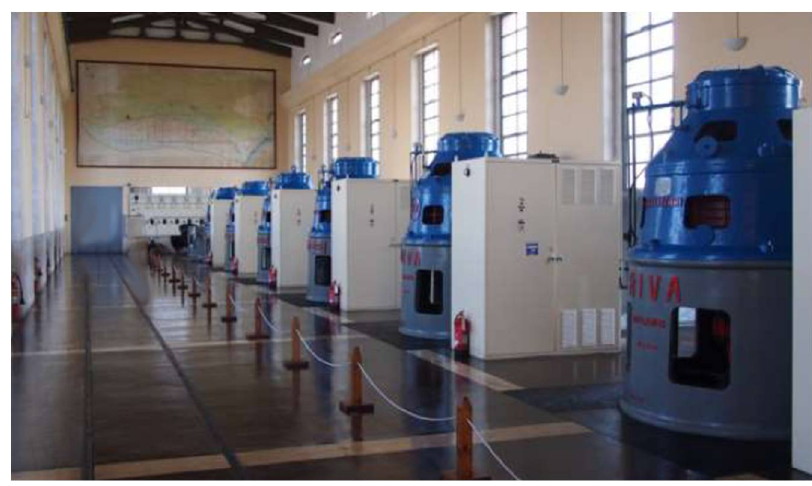
Figure 2. Hydraulic pumps in Mazzocchio’s pumping station.